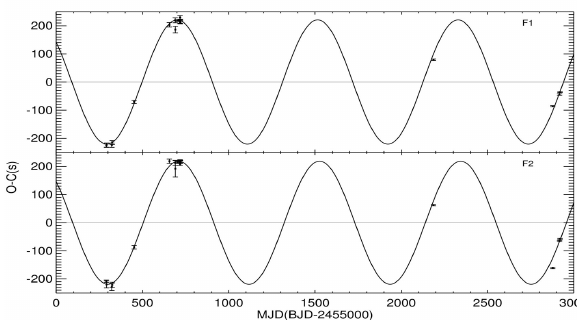
Figure 5. PG 1613+426 O-C results for F1 (top) and F2 (bottom). The curves represent the best sinusoidal curve fits. Each dot represents one night of observation.